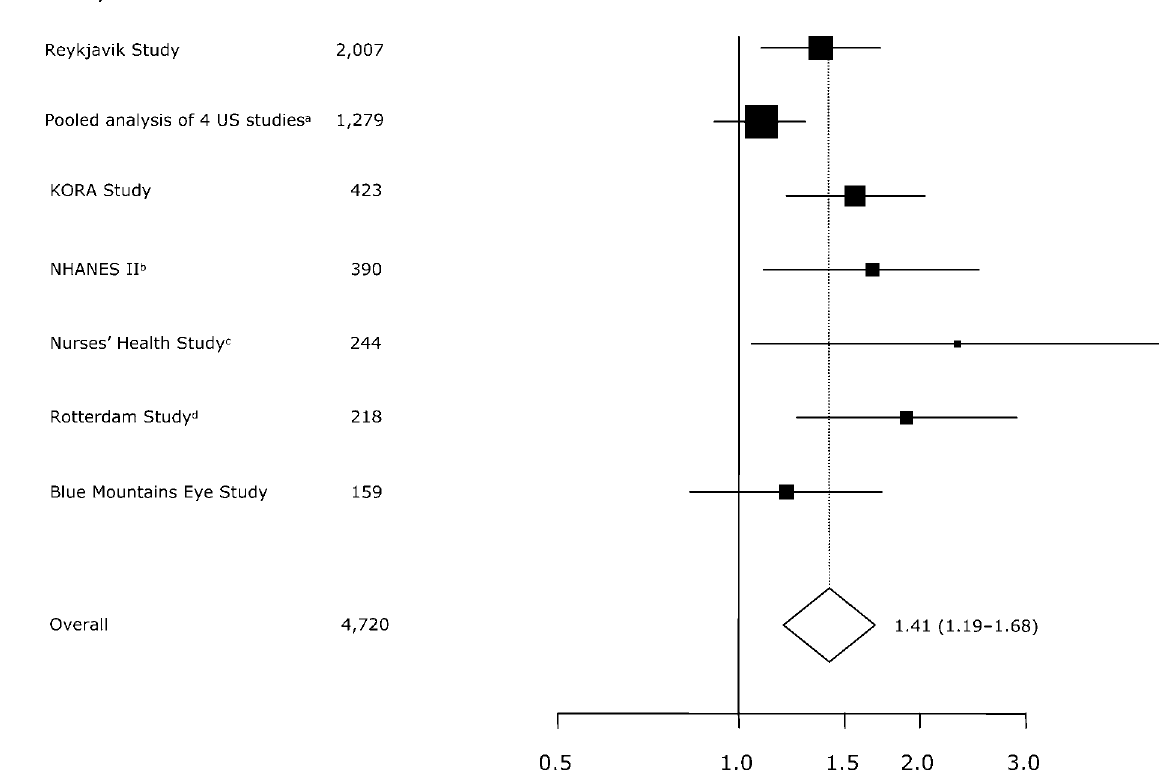
Figure 3. Meta-analysis of Reported Data from Prospective Studies in Essentially General Western Populations of CHD Risk in Individuals with eGFR MDRD of , 60 versus (cid:3) 60 ml/min/1.73 m 2 , with Adjustments Reported for Several Established Cardiovascular Risk Factors The size of the data markers is proportional to the inverse of the variance of the risk ratios. Overall estimate calculated using fixed effect meta-analysis. Random effects overall relative risk 1.32, 95% CI 1.19–1.47. Test for heterogeneity: v 2 ¼ 12.9 with 6 df, p ¼ 0.045; I 2 ¼ 56% (95% CI 0%–80%). For adjustments see Table 3. KORA, The MONICA/KORA Augsberg Study; NHANES, National Health and Nutrition Examination Survey.